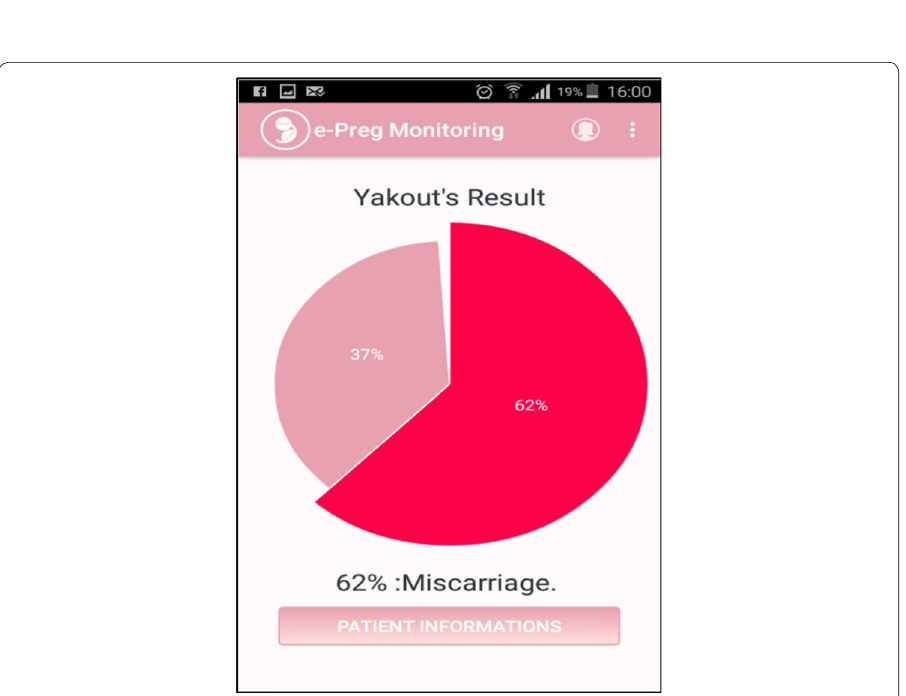
Fig. 7 Screenshot of doctor’s result